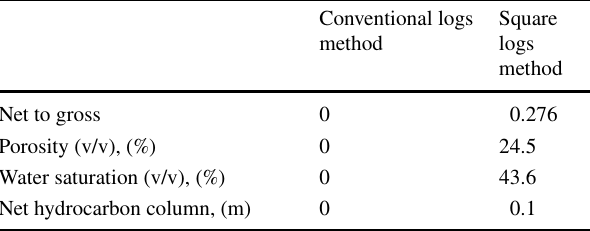
Table 2 Petrophysical parameter calculated from conventional (the standard resolution) and square (high resolution) logs methods. NISOC cutoffs used: effective porosity > = 0.045, effective water sat- uration <= 0.5, volume of clay < = 0.5